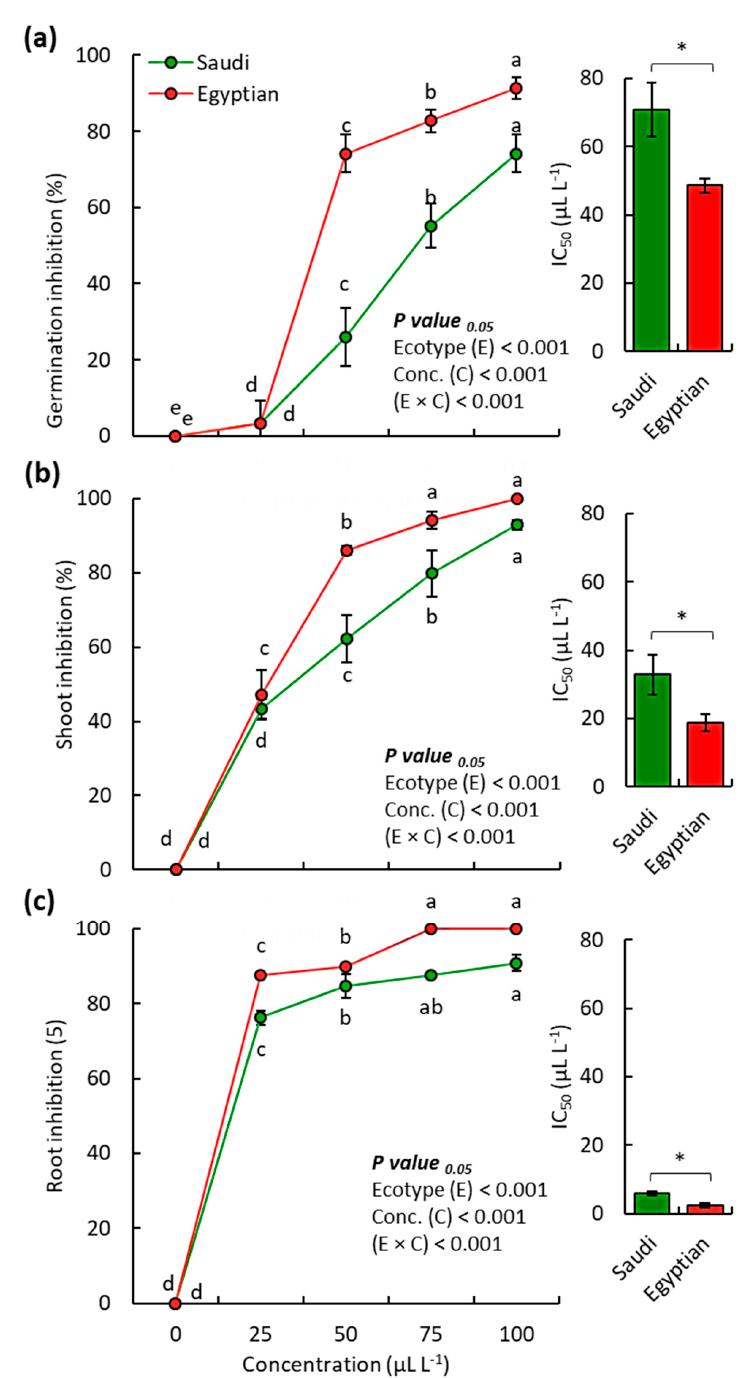
Figure 3. Phytotoxic activity of the EO from Saudi and Egyptian ecotypes of C. procera on the ( a ) seed germination, ( b ) seedling shoot growth, and ( c ) seedling root growth of Bidens pilosa . * p < 0.05 (two ‐ tailed t ‐ test). Different letters per each line mean significant difference (one ‐ way randomized blocks ANOVA). Data are mean value ( n = 3) and the bars represent the standard error.